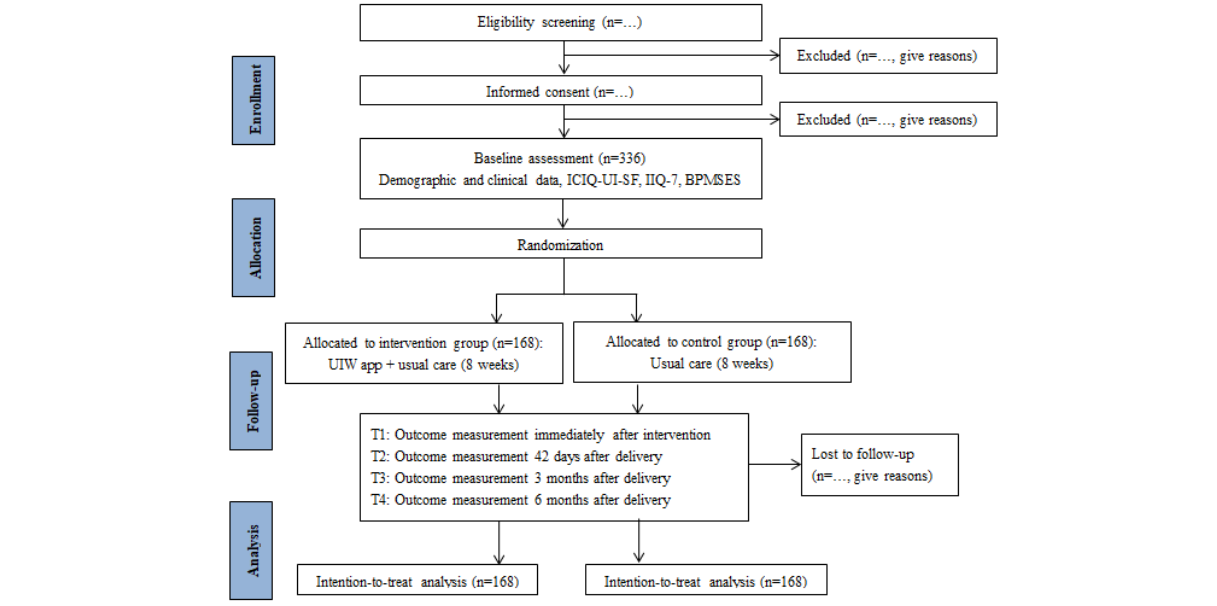
Figure 2. Trial flowchart according to CONSORT (Consolidated Standards of Reporting Trials). BPMSES: Broome Pelvic Muscle Self-Efficacy Scale; ICIQ-UI-SF: International Consultation on Incontinence Questionnaire-Urinary Incontinence Short Form; IIQ-7: Incontinence Impact Questionnaire-7; UIW: Urinary Incontinence for Women; T1: immediately after intervention; T2: 42 days after delivery; T3: 3 months after delivery; T4: 6 months after delivery